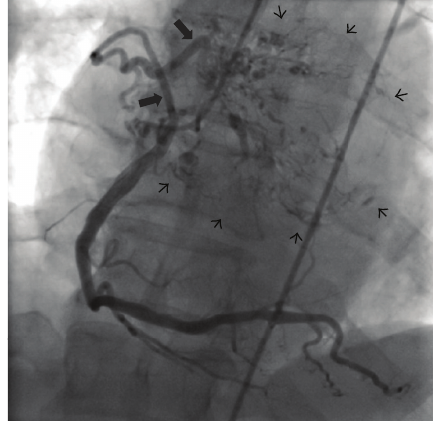
Figure 2: Coronary angiography image with a conus branch of the rightcoronary artery (largeblack arrows)vascularizing themyxoma with a wide area vascular network (small black arrows).